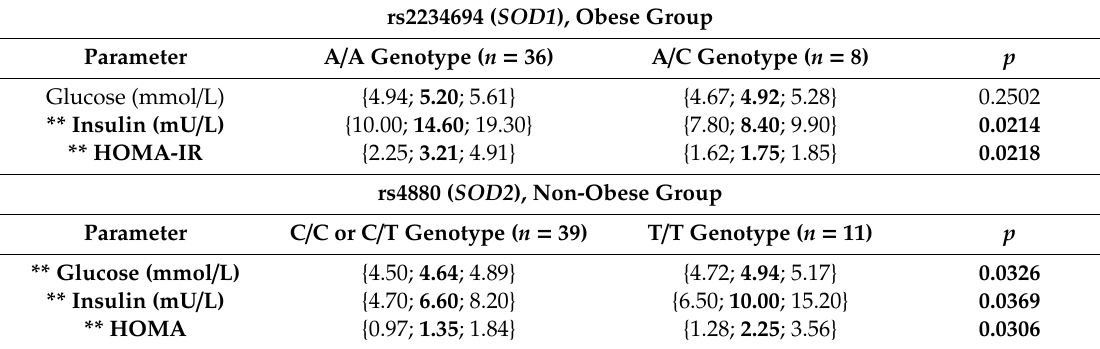
Table 12. The values of selected carbohydrate metabolism and insulin resistance parameters, in context of genotypic variability of rs2234694 ( SOD1 ) and rs4880 ( SOD2 ). rs2234694 ( SOD1 ), Obese